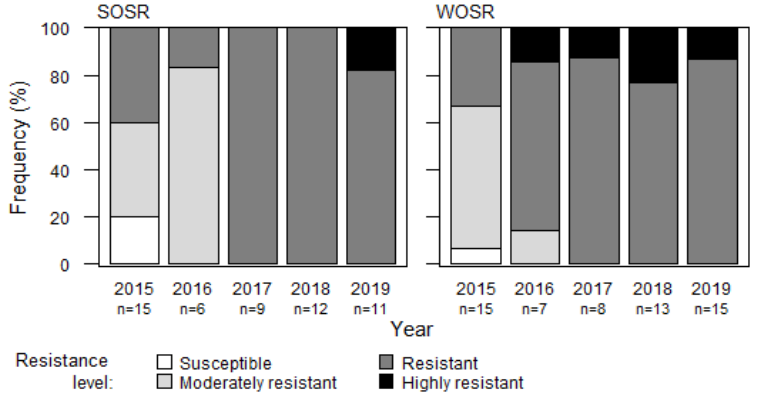
Fig. 2. The distribution of pollen beetle populations according to resistance levels against lambda- cyhalothrin by years and host crops, classified according to IRAC No 011 (IRAC 2015) and Table